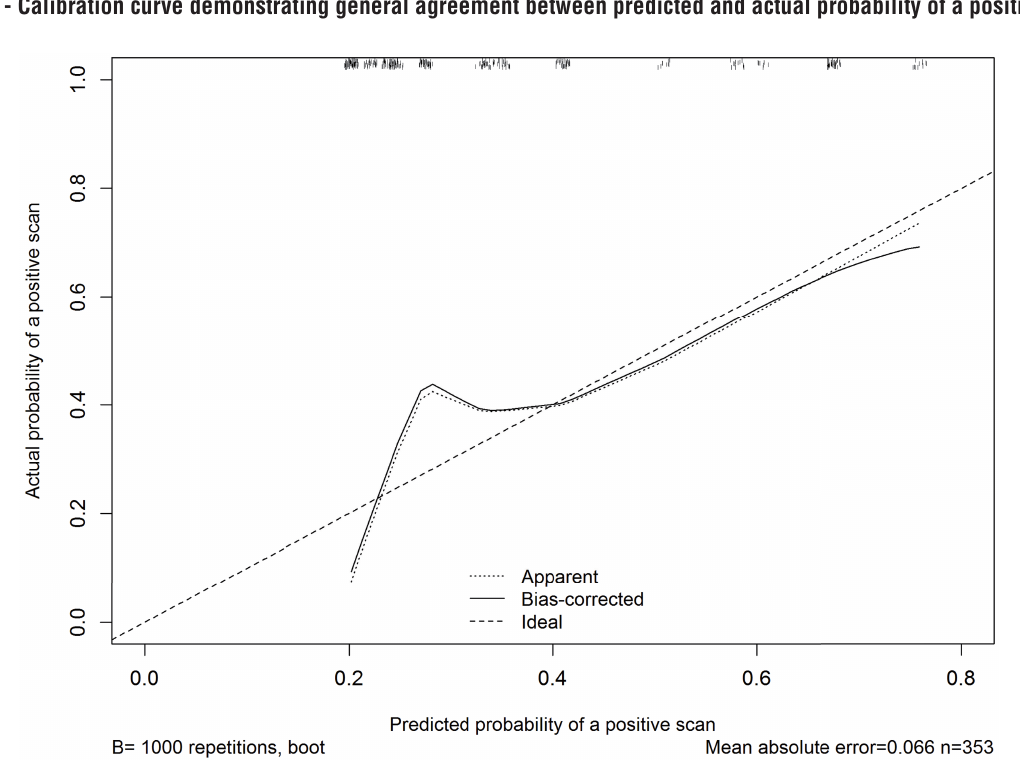
Figure 4 - Calibration curve demonstrating general agreement between predicted and actual probability of a positive